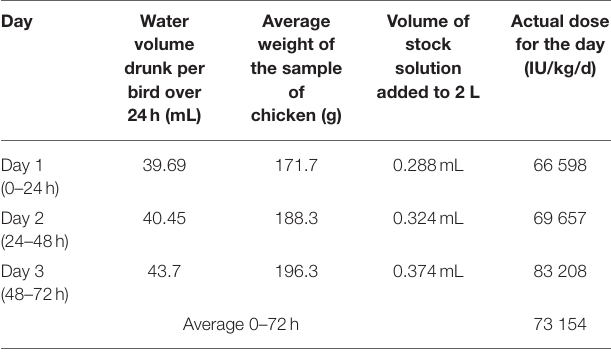
TABLE 1 | Colistin sulfate administration and calculated average dose